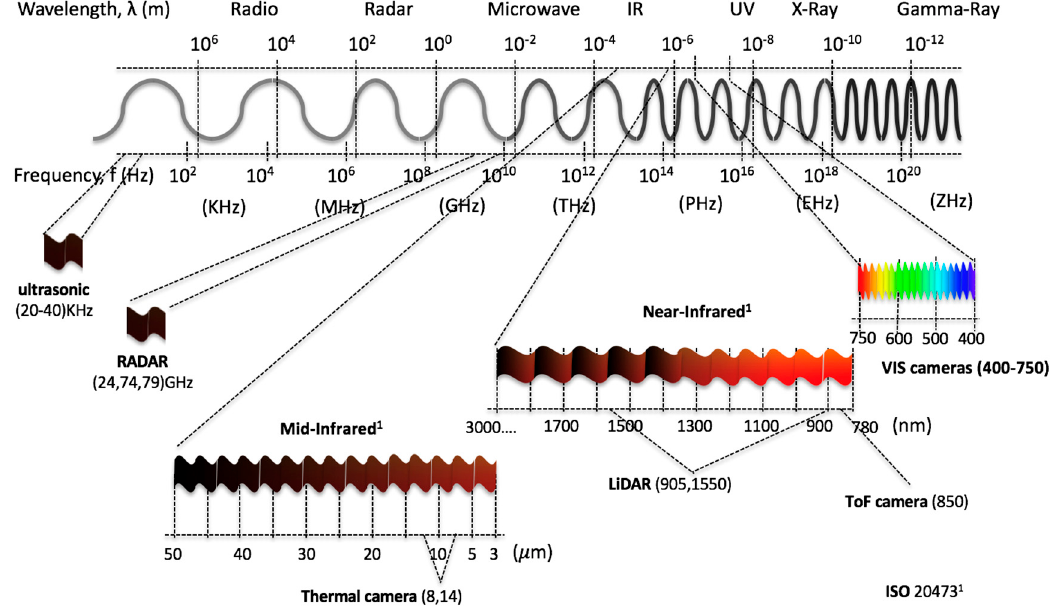
Figure 2. An overview of different spectra used for perception systems in autonomous vehicles.